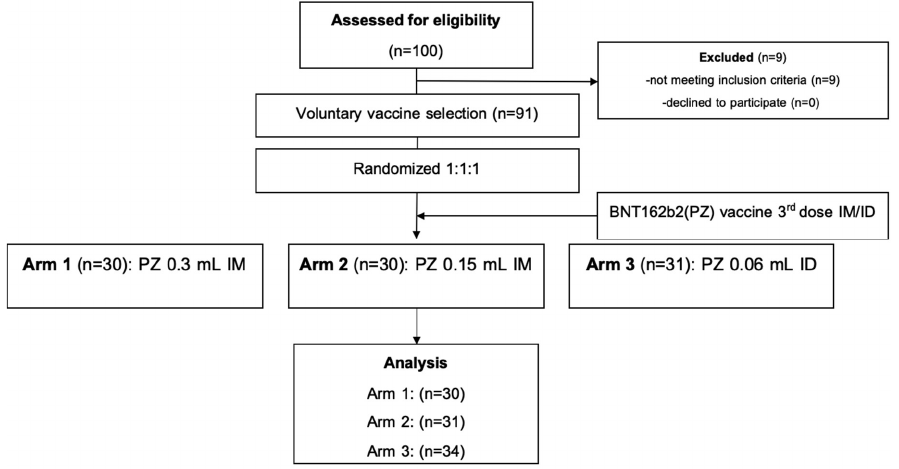
Figure 1. CONSORT chart. Abbreviations: intradermal (ID); intramuscular (IM).